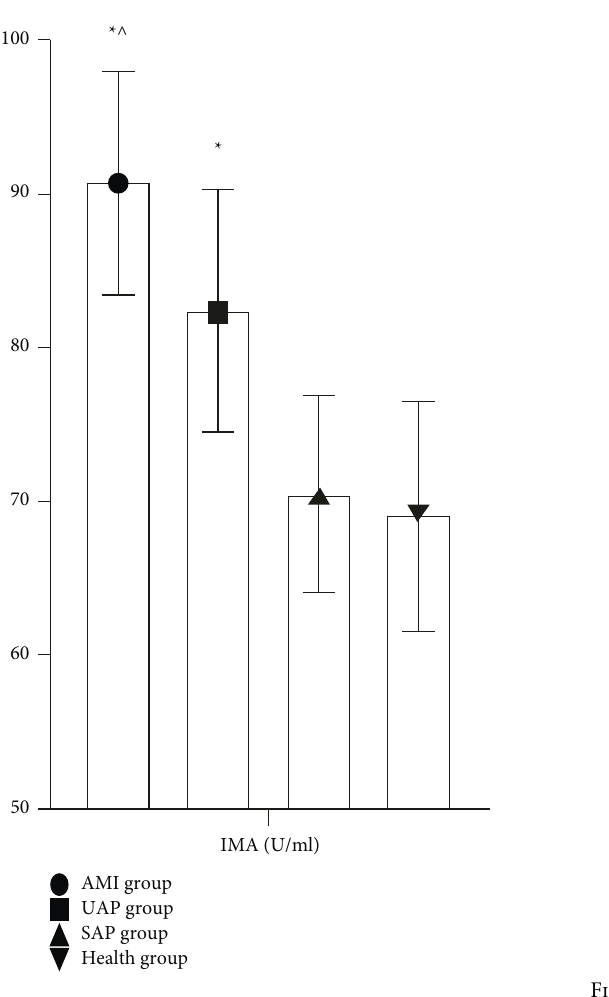
Figure 7: Serum IMA level (U/ml). Note: ∗ is P < 0 . 05 compared with SAP group and health group, and ∧ is P < 0 . 05 compared with UAP group.